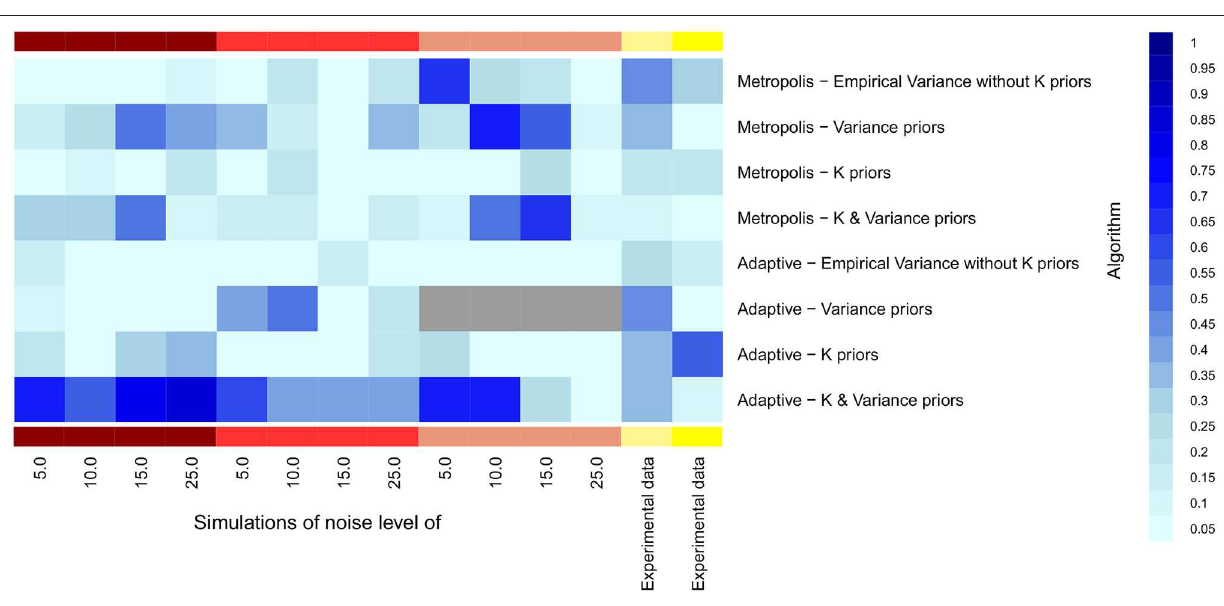
unknown and have to be inferred from experimental